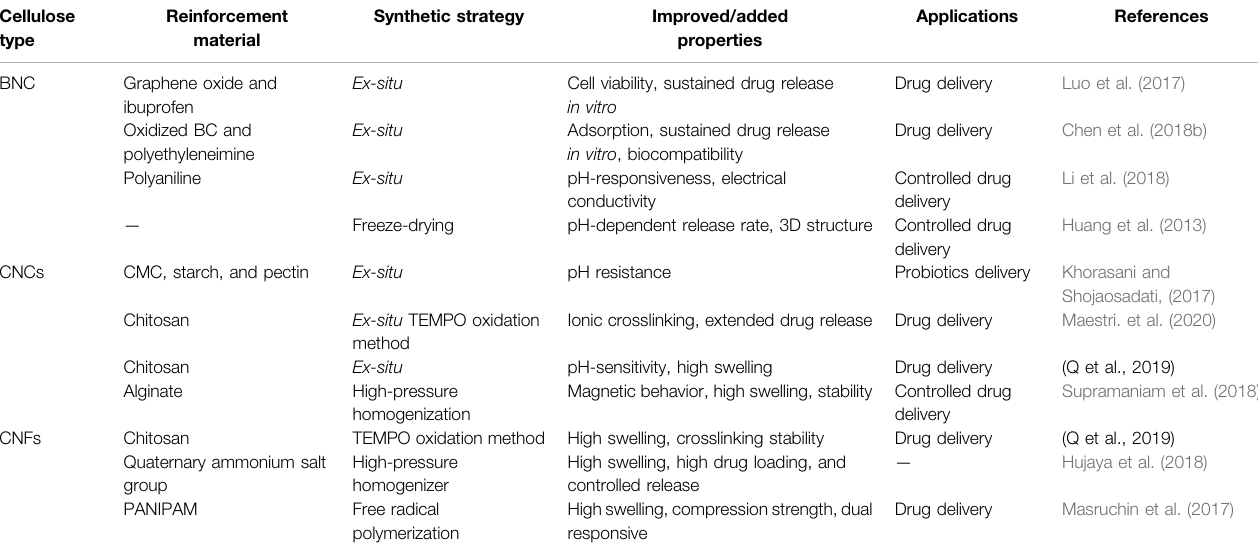
TABLE 4 | The improved properties and drug delivery applications of different nanocellulose-based composites. Cellulose